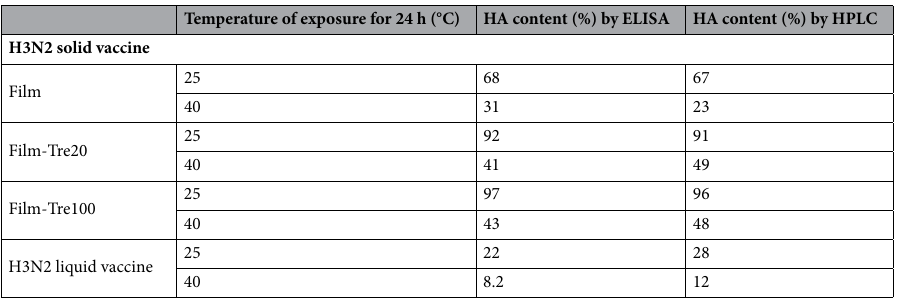
Table 1. HA content measured by HPLC and ELISA by exposure at 25 °C and 40 °C for 24 h after 24 h of drying process at 25 °C.